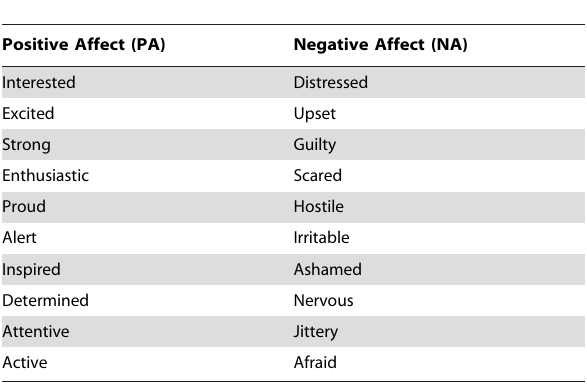
Table 2. Positive and Negative Schedule (PANAS)